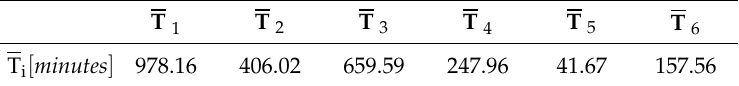
Table 7. Unconditional times T i [ minutes ] for the 6-state